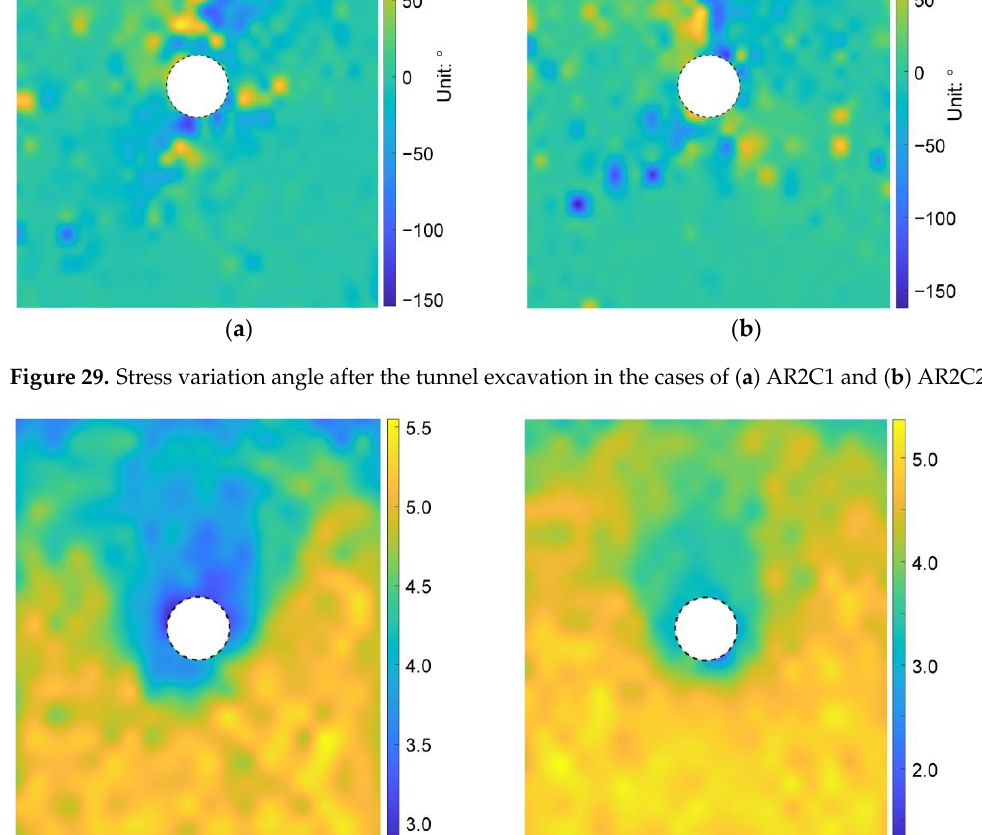
Figure 30. Distribution of coordination numbers of the ground after the tunnel excavation in the cases of ( a ) AR2C1 and ( b ) AR2C2.